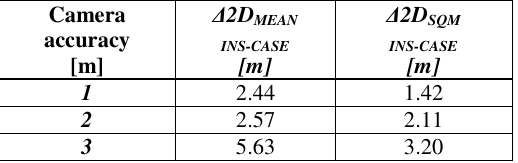
Table 5. The results obtained by the commercial